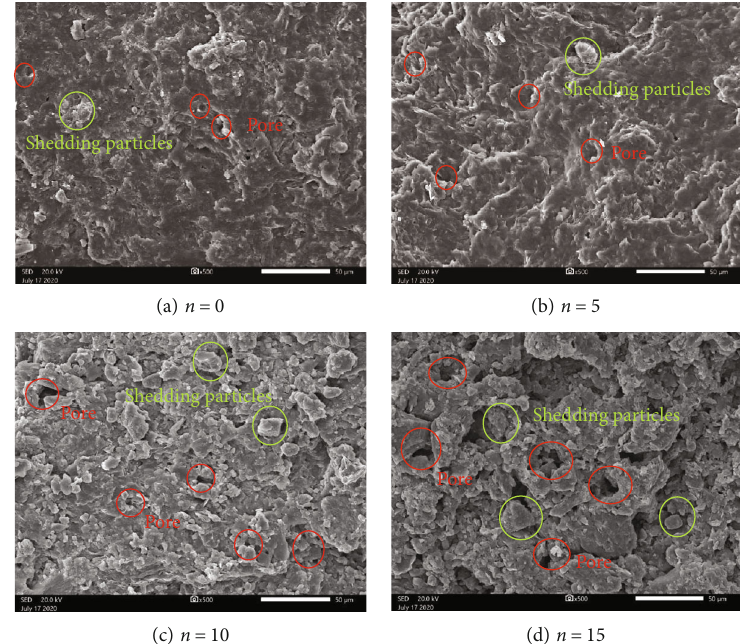
Figure 3: Scanning electron microscopy observation for carbonaceous mudstone in parallel layered